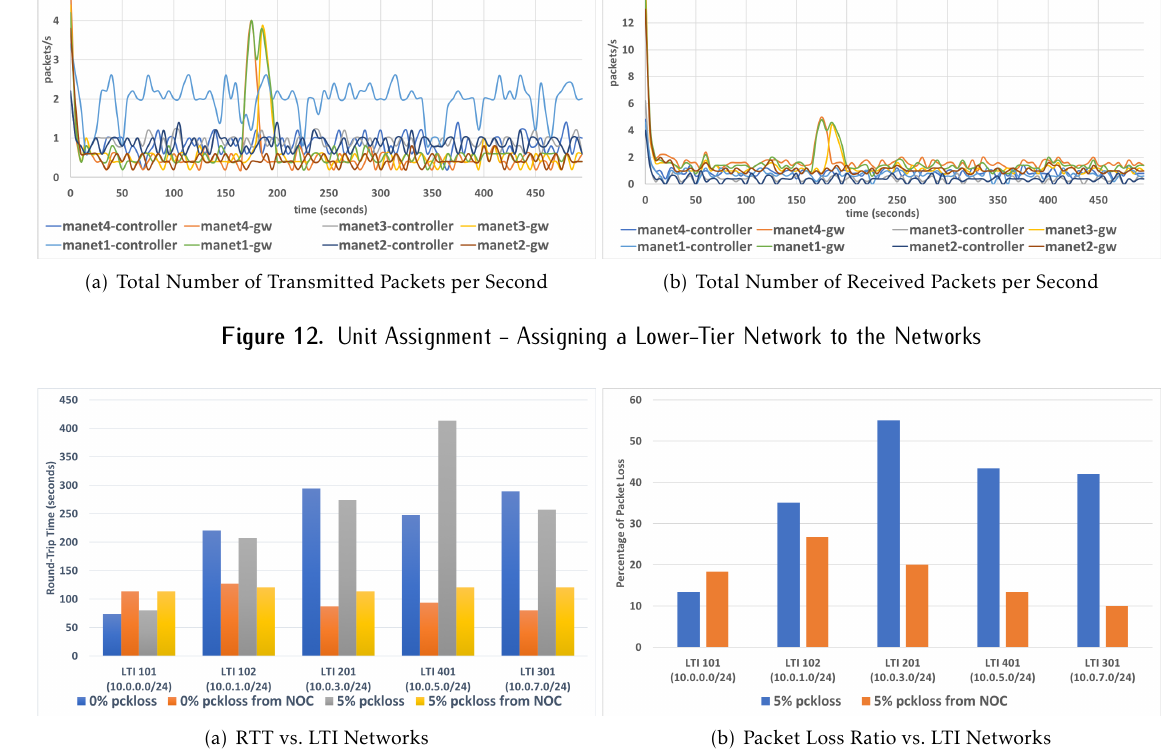
Figure 13. Tests of